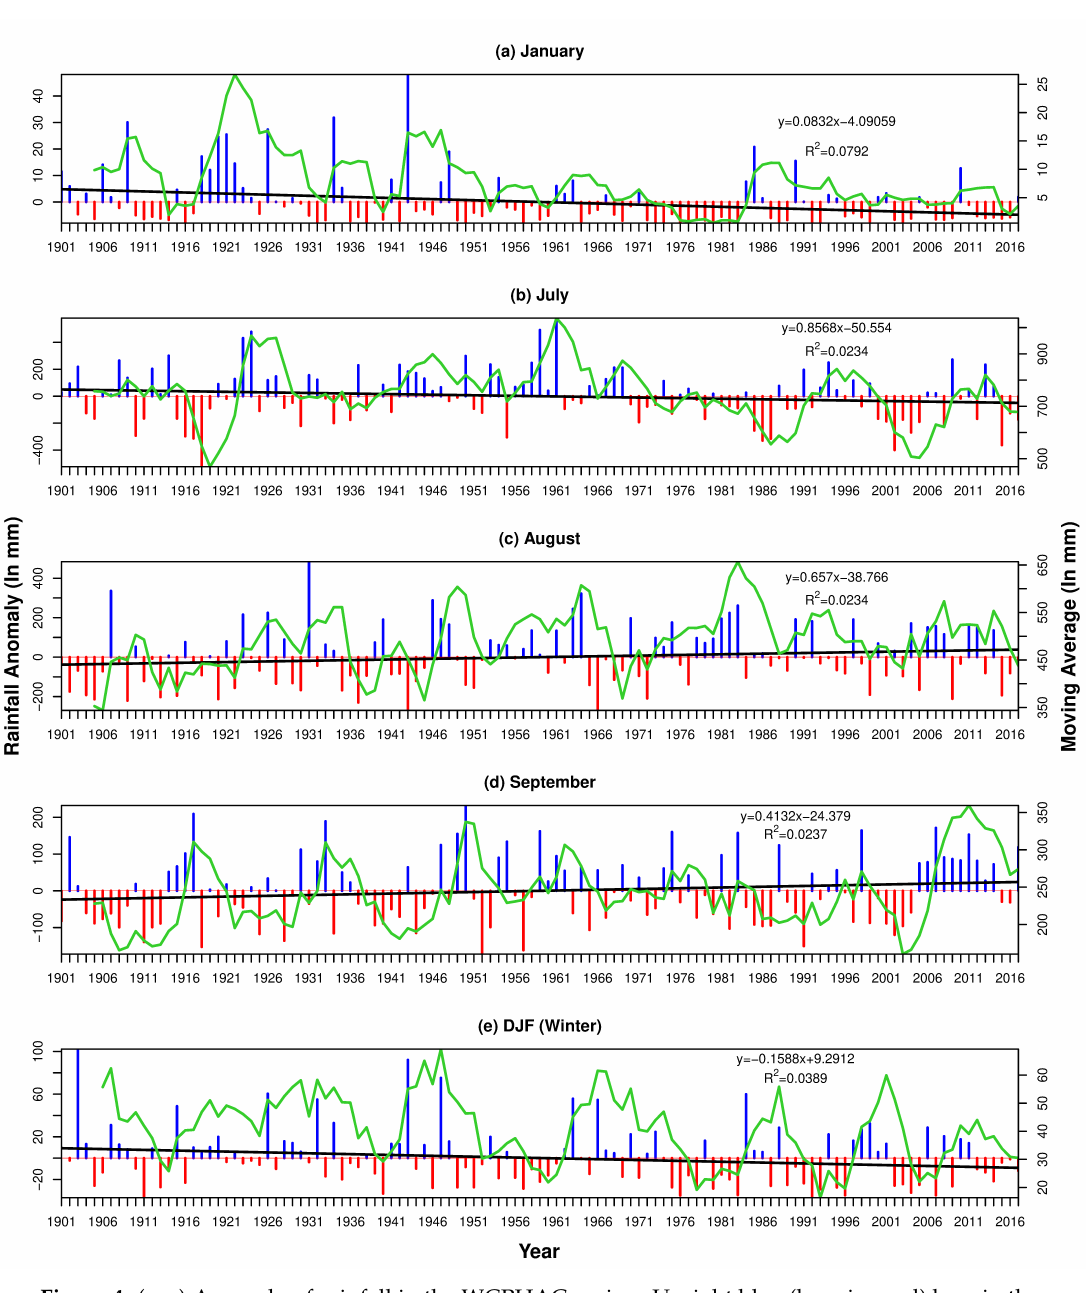
Figure 4. ( a – e ) Anomaly of rainfall in the WCPHAC region. Upright blue (hanging red) bars in the figure represent positive (negative) anomaly and the black color solid line is the linear regression line of the rainfall trend. Here, the green solid line is indicative of 5 years moving average of the